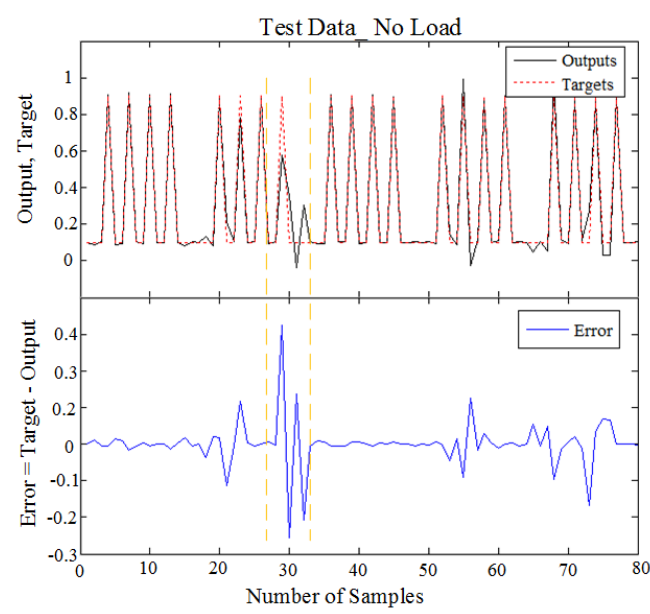
Figure 16. The Error between Real Output and Desired for Testing Data Set in 10% of Full Load.